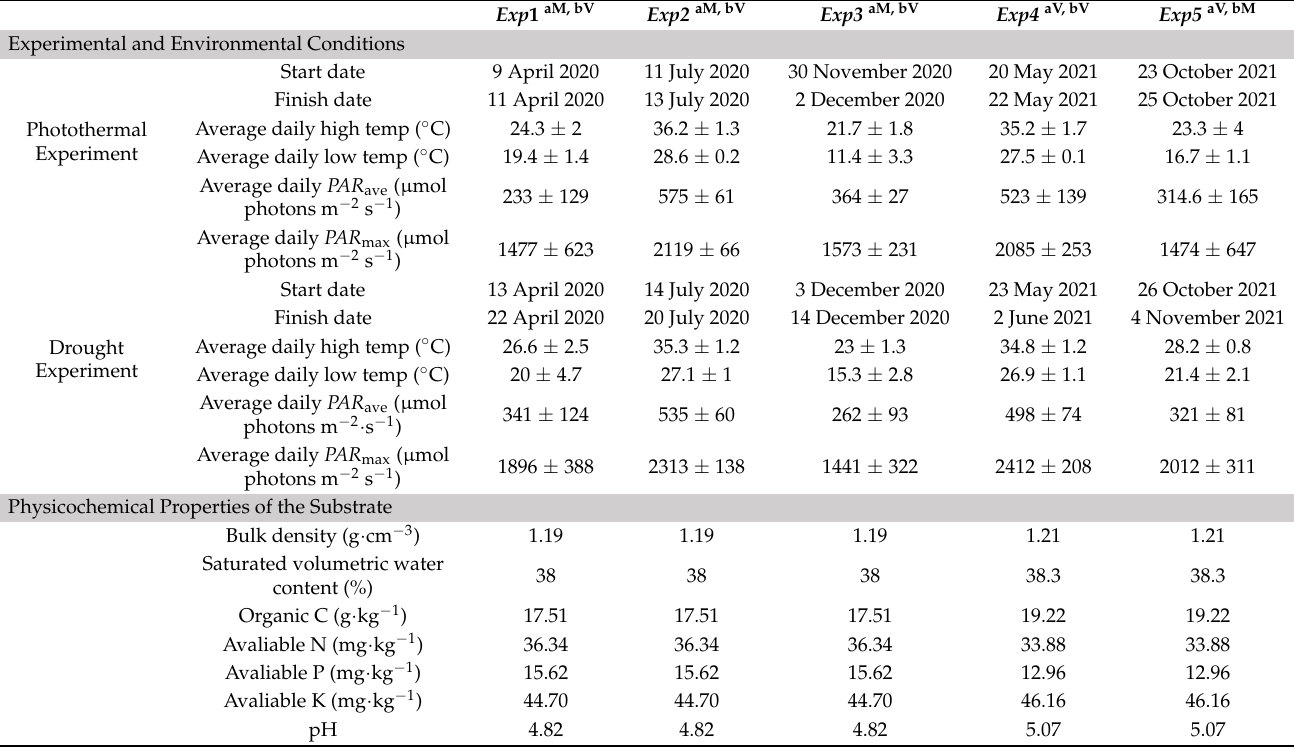
Table 2. Detailed information on the experimental conditions and physicochemical properties of the substrate. Exp 1 aM,bV Exp2 aM,bV Exp3 aM,bV Exp4 aV,bV Exp5